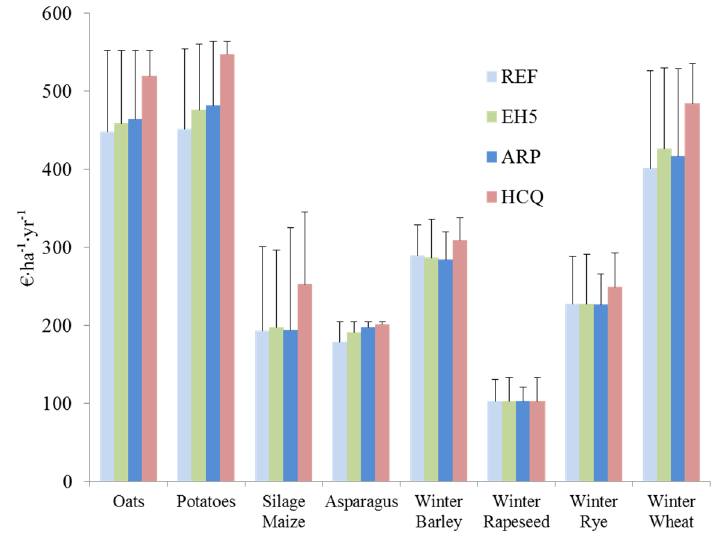
Figure 12. Average costs of irrigation for several crops and climate projections in the period 2018–2052 (bar: medians, whiskers: 10th